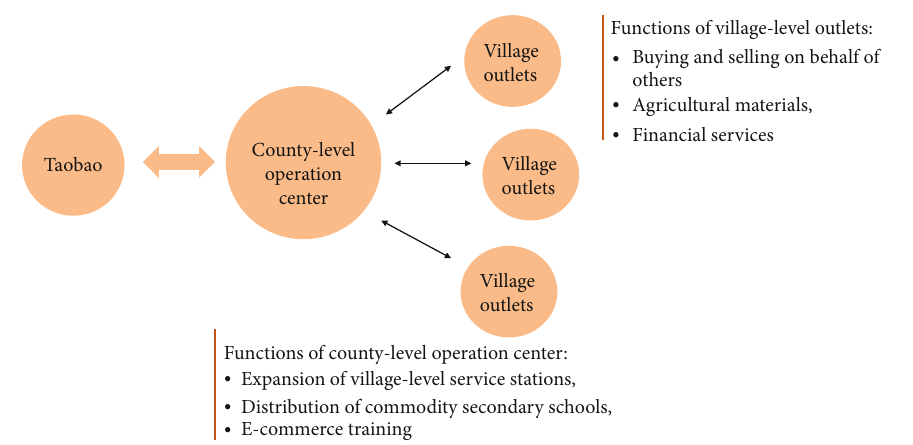
Figure 2: Schematic diagram of rural Taobao “ County-to-Township Communication ” service